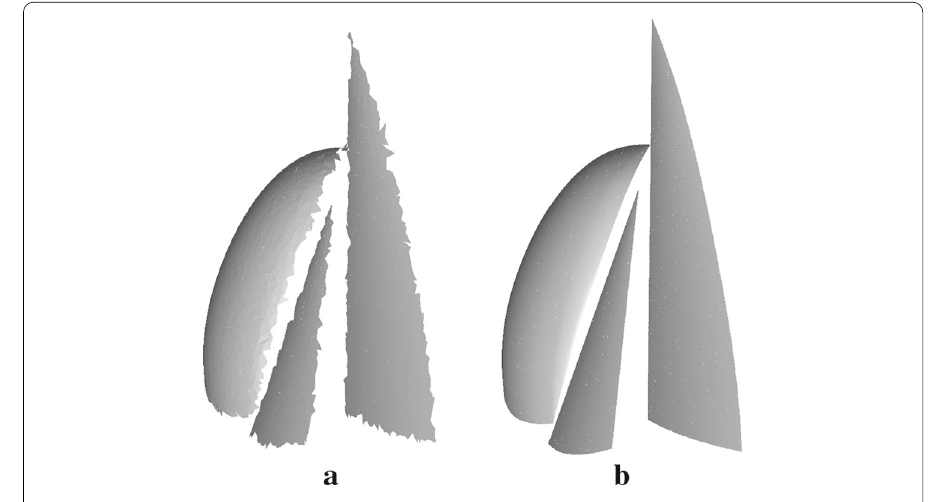
Fig. 35 Reconstructed surface approximation of sails immersed into a block-shaped background mesh. a Without adaptive refinement of background mesh ( ∼ 800,000 elements). b With four levels of adaptive refinement (ca. 4.5 Mio. elements)